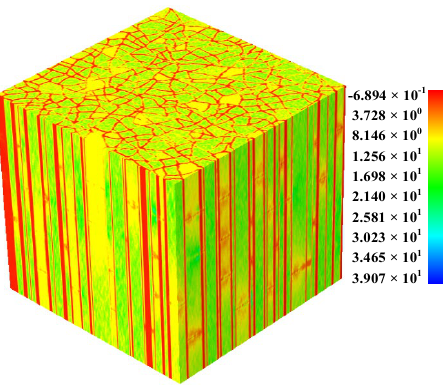
( d ) Figure 12. Configurations of columnar jointed basalt. ( a , b ) Structural descriptions of columnar jointed basalt in transverse sections [35]. ( c ) A numerical model for the columnar jointed basalt. ( d ) The spatial shape of the joints is characterized. Table 2. Material properties of the CJRM FE model [58]. Materials